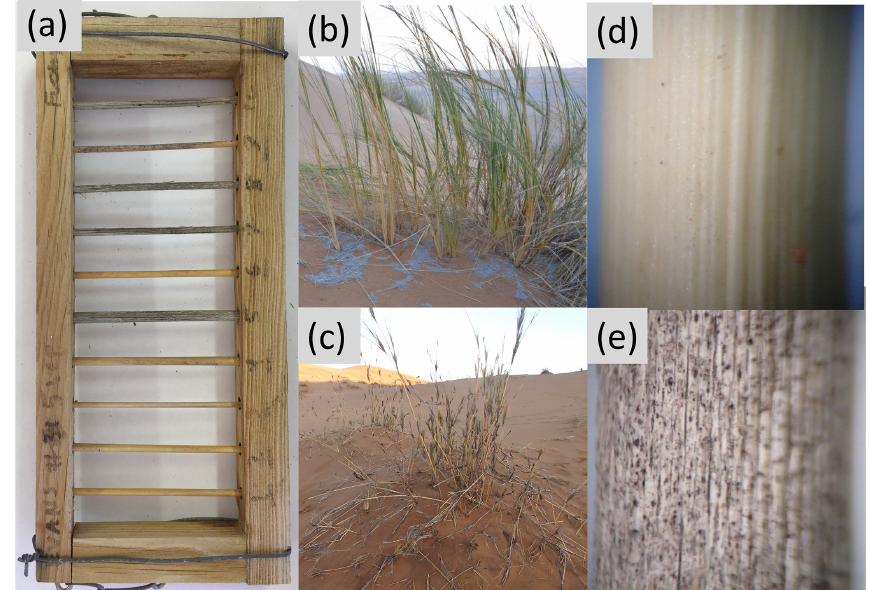
Figure A2. (a) Example of a litter rack used instead of litter bag. The “rungs” of the “ladders” are Stipagrostis sabulicola stems ∼ 0 . 5cm in diameter and 9cm long. (b) Living S. sabulicola hummock growing in the dunes. (c) Dead S. sabulicola tillers like those used in this study. (d) Close up image of a recently senesced (early-stage) tiller with intact cuticles and little fungal growth. (e) Close up image of a late-stage tiller with cracked cuticle surface and substantial colonization by dark pigmented fungi.